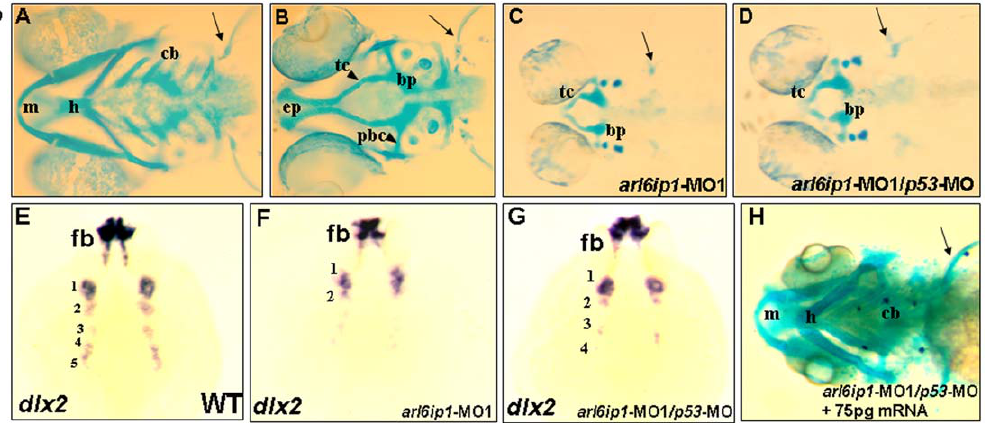
Figure 2. Craniofacial cartilage defects in the arl6ip1 morphants. Ventral views (A, C, D, H) or dorsal view (B) of 4-dpf embryos stained with Alcian blue to reveal craniofacial cartilage. Either pectoral fin (pf) or cartilage derived from mandibular (1st arch, m), hyoid (2nd arch, h), and ceratobranchial (3rd–7th arches, cb) arches was observed in control embryos (A). Dorsal views of anterior neurocranial cartilage in wild-type embryos showed paired trabeculae (tc) and an ethmoid plate (ep) (B). However, craniofacial cartilage and pectoral fin were absent in the arl6ip1- deficient (C) and arl6ip1 -MO1/ p53 -MO-injected embryos (D). In the anterior neurocranial cartilage, trabeculae were severely reduced in both of these embryos, and the ethmoid plate was absent (C, D). dlx2 was expressed in migratory neural crest precursors of pharyngeal arch, as shown in dorsal views at 36 hpf in wild-type (E). Both arl6ip1 -MO1-injected (F) and arl6ip1 -MO1/ p53 -MO-injected embryos (G) had reduced dlx2 expression, and the reduction of dlx2 was prominent in posterior arches at 24 hpf. In addition, dlx2 was expressed normally in the forebrain (E, F, G). The severe chondrocranium and pectoral fin defects in arl6ip1 -MO1/ p53 -MO-injected embryos were rescued by injection of 75 pg wobble arl6ip1 mRNA (H). bp, basal plate; pbc, posterior basic capsular commiss. Arrows, pectoral fin.